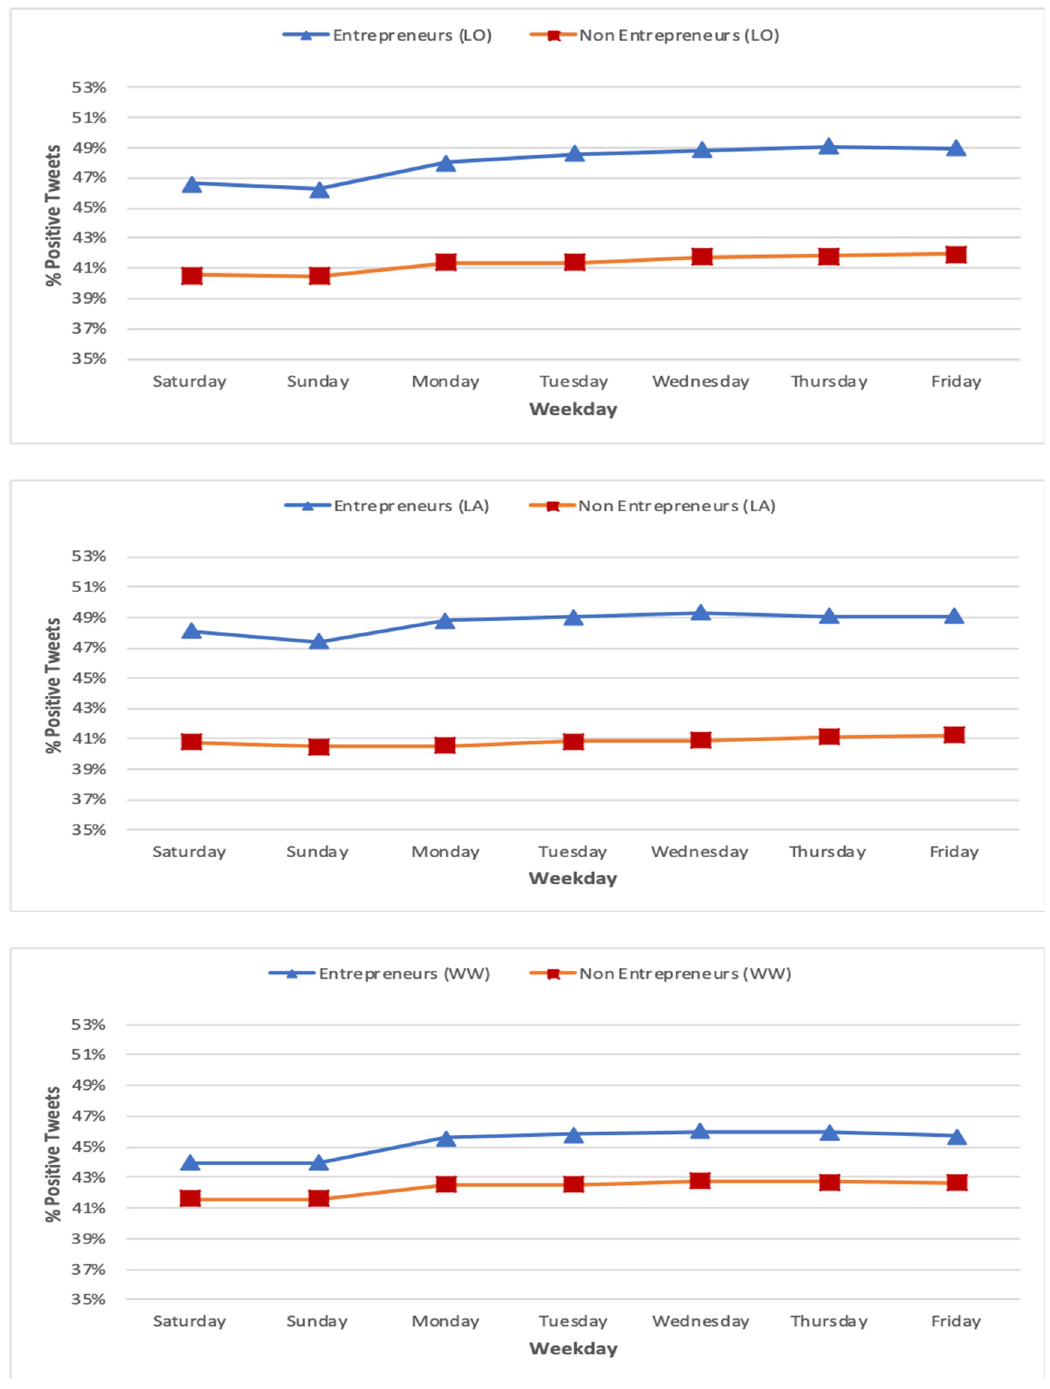
Fig 2. Tweet emotional comparison per weekday between entrepreneurs and non-entrepreneurs for London (top), Los Angeles (middle) and worldwide (tweet level).